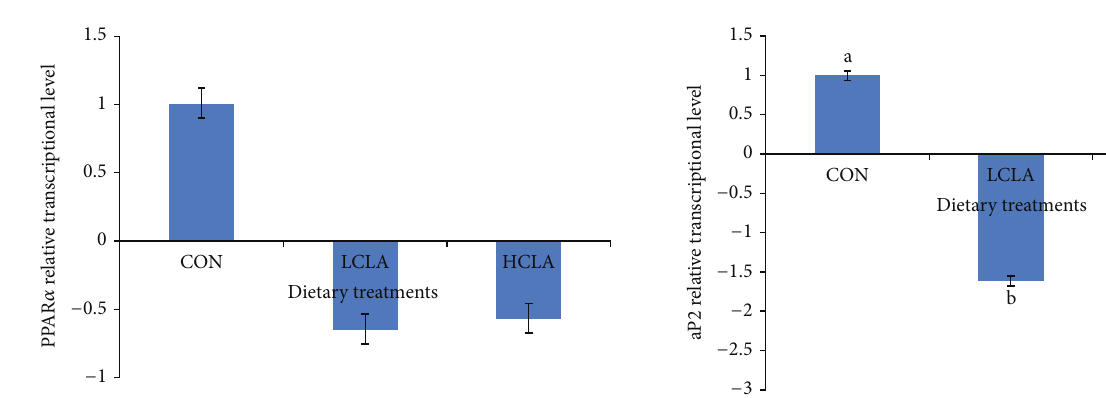
Figure 1: Comparison of PPAR 𝛼 relative transcriptional level in the abdominal fat of chickens fed diets with CON, LCLA, and HCLA. Values were normalized with reference genes, 𝛽 -actin, and GAPDH. Then, treated samples were expressed relative to transcriptional level of CON group. Values are mean ±1 standard error ( 𝑛 = 10 ). CON: without CLA; LCLA: low CLA; HCLA: high CLA. LCLA and HCLA found not to be of significant difference compared to CON group ( 𝑃 > 0.05 ).